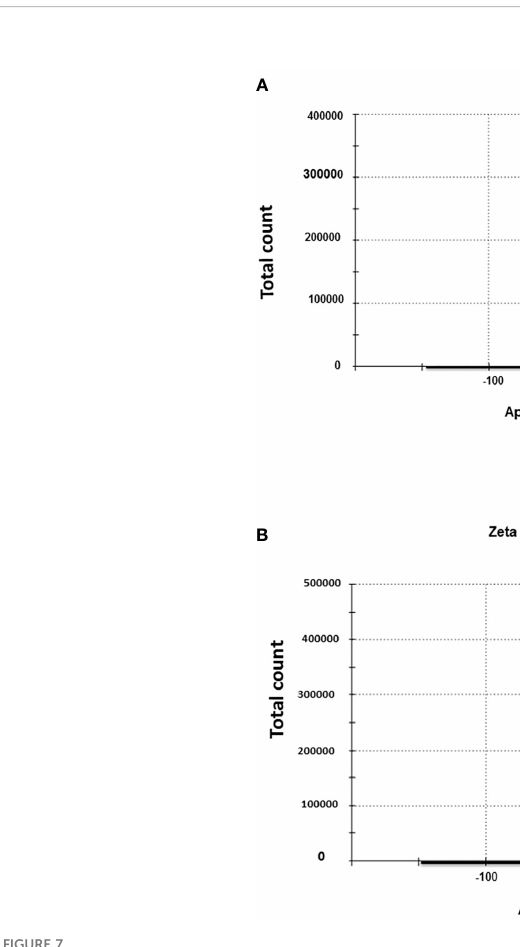
FIGURE 7 Zeta potential distribution of Au-NPs biosynthesized using the extracts of macroalgae (A) C. trinodis and (B) C. prolifera